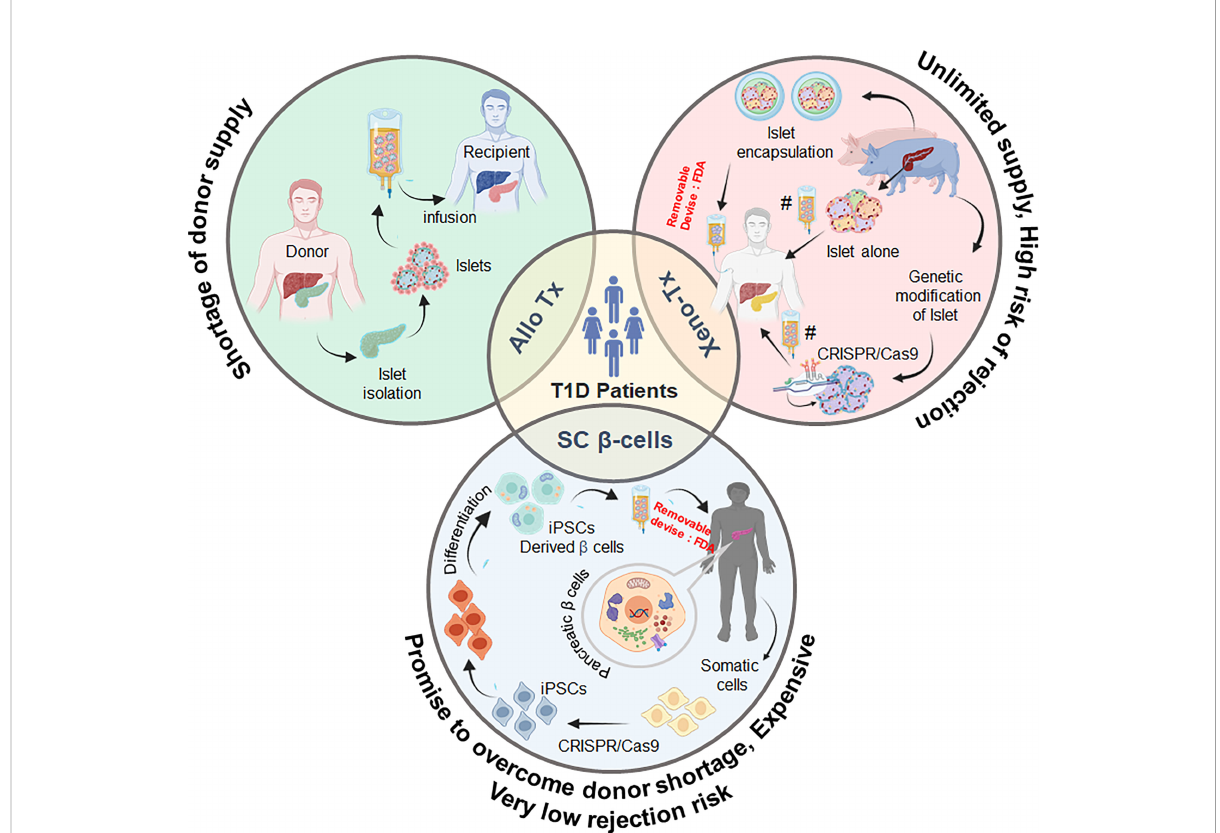
FIGURE 1 Schematic representation of the promising sources of pancreatic b cells and possible strategies for the treatment and management of type 1 diabetes. Tx, transplantation; SC, stem cell; iPSC, induced pluripotent stem cells. As per FDA recommendations, any xeno- or stem cell-derived cell will have to be contained in a removable device for use in